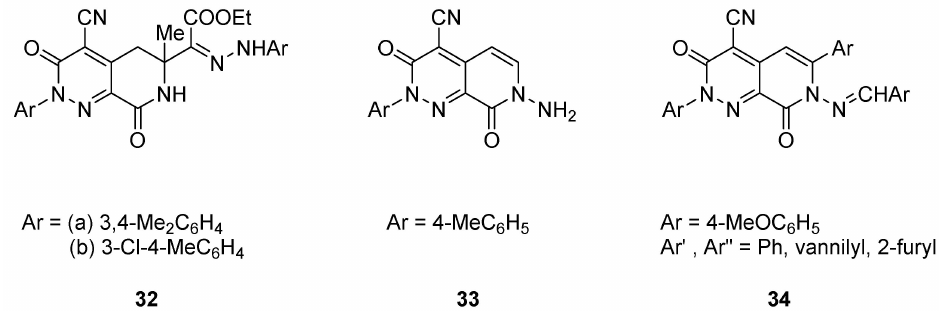
Figure 2. Miscellaneous pyridopyridazine-3,8-dione